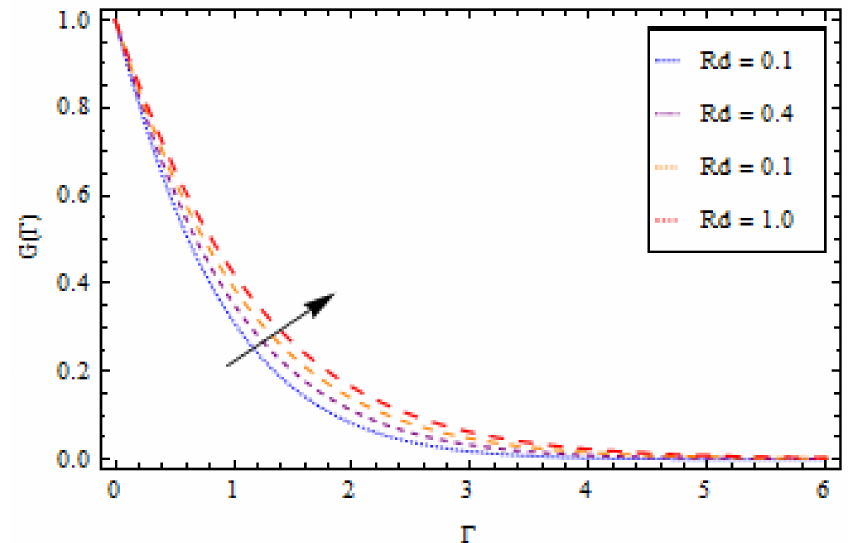
Figure 7. Impact of Rd on temperature profile G ( Γ ) , when K = 0.5, Pr = 0.5, λ = 0.5, κ = 0.5, γ = 0.5, Sin τ = 1.0, A = 0.5.